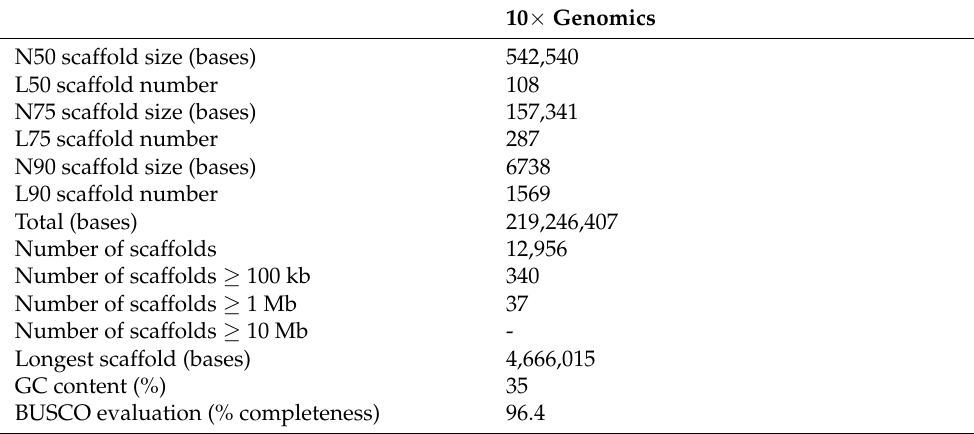
Table 1. R. mucronata genome assembly statistics.